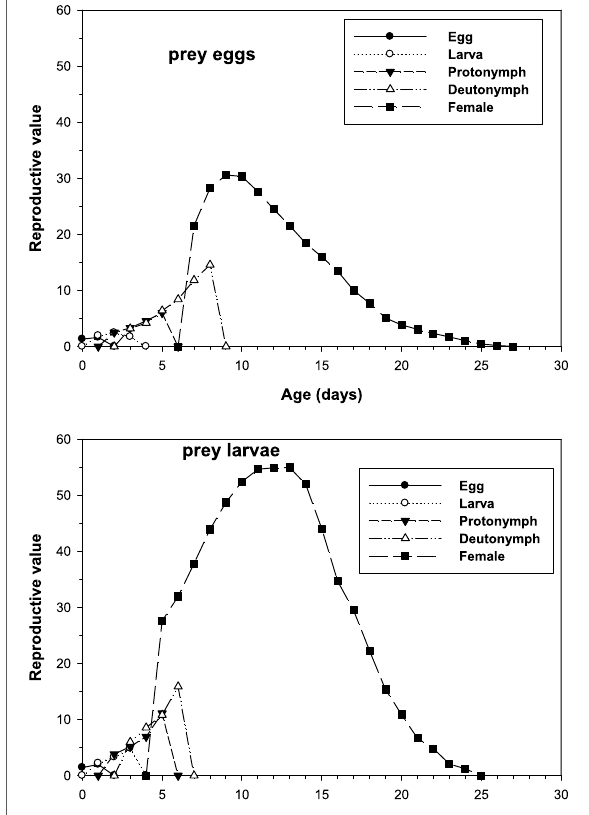
Fig. 4 Age-stage specific reproductive values ( V xj ) of Blattisocius mali on eggs and larvae of Tyrophagus putrescentiae